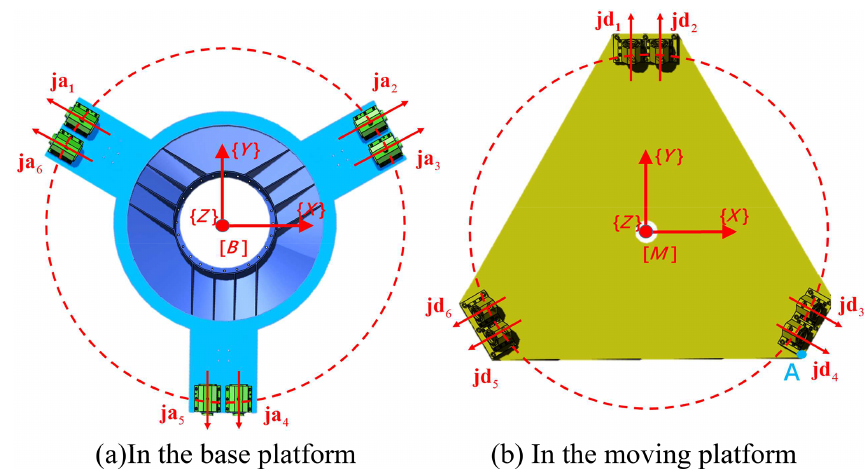
Figure 3. Axes of Hooke’s joints at the base and moving